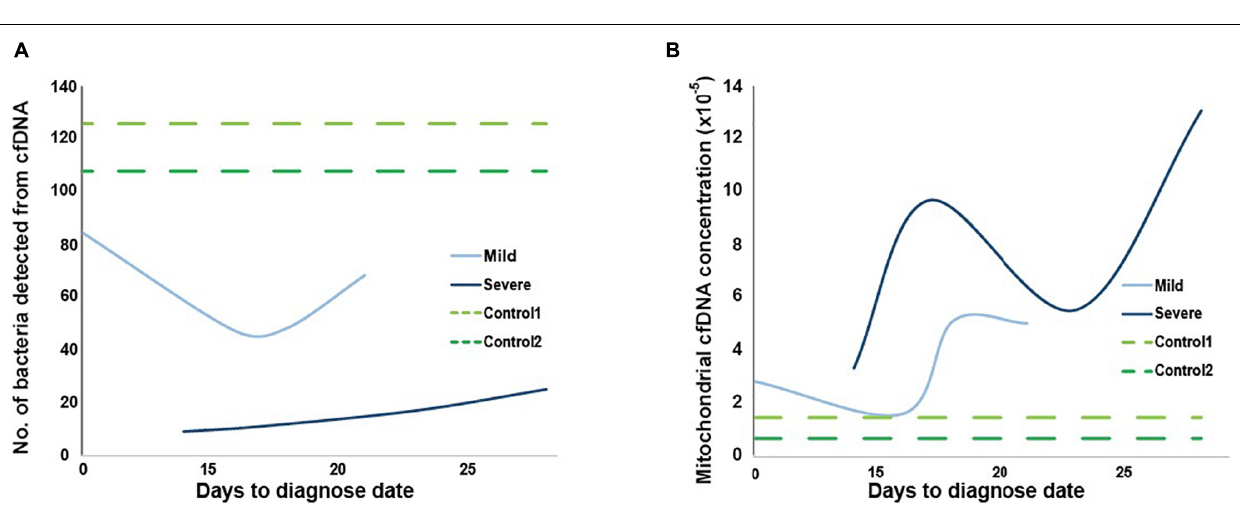
FIGURE 6 | Microbial and mitochondrial cfDNA from two controls and two mild and severe cases. Number of bacteria types detected in panel (A) and mitochondrial cfDNA concentration in panel (B) from cfDNA of plasma collected at four time points for mild (light blue) and severe (dark blue) cases, and at once for the two cases (green, time for dotted lines are invented only for